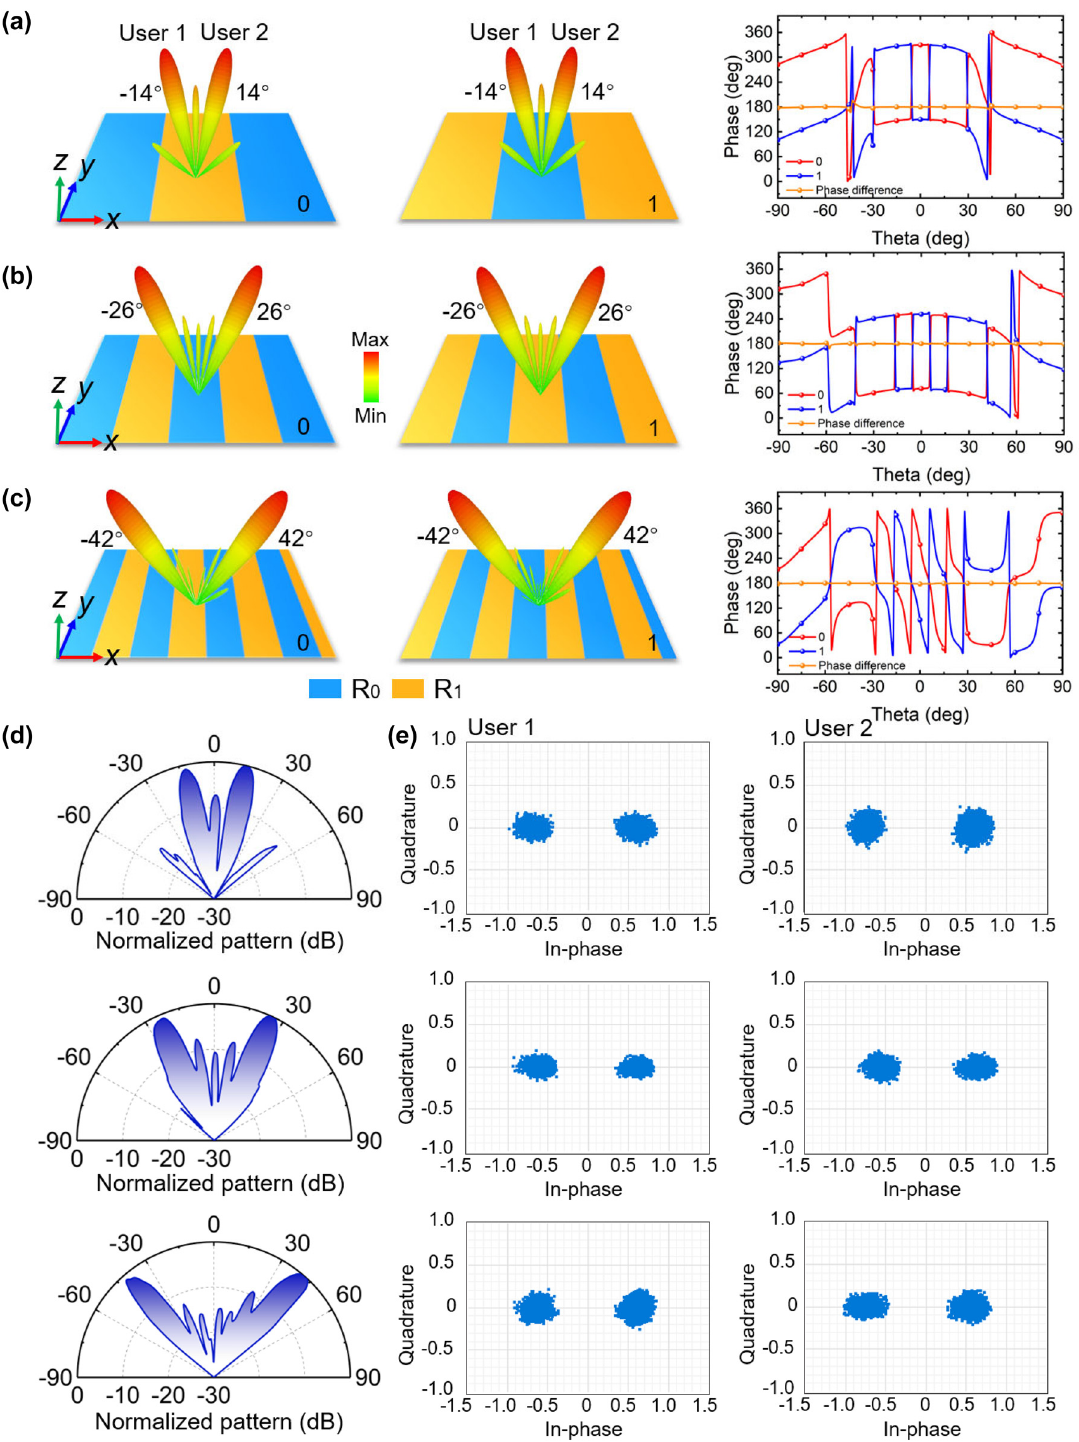
Figure 4: Simulated/measured far-field scattering patterns and measured constellation diagrams with versatile mapping relationships between digital information and spatial coding patterns. Simulated scattering patterns and the phase difference between symbol “0” and “1” corresponding to spatial coding patterns of (a) “R